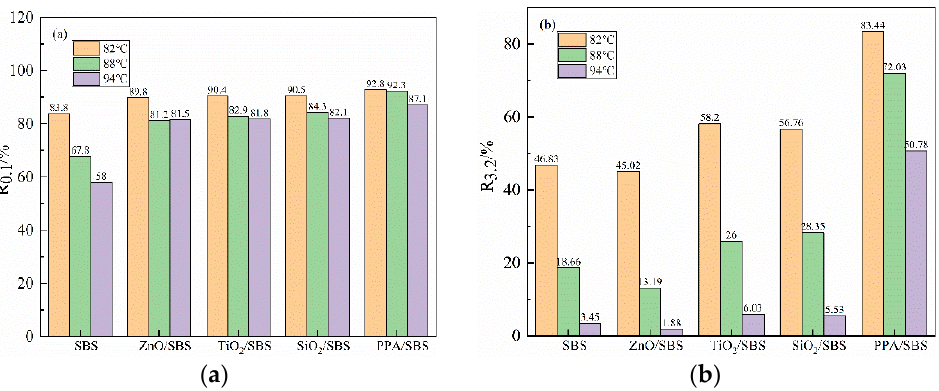
Figure 1. The deformation recovery rate of modified asphalt under different conditions after RTFO aging: ( a ) R 0 . 1 ; ( b ) R 3 . 2 .